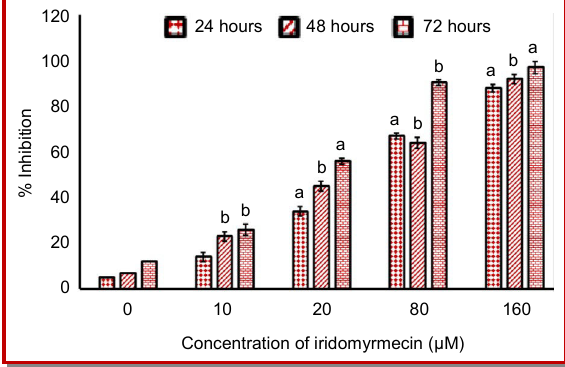
Figure 1: Inhibition of cell proliferation by iridomyrmecin in human cervical cancer cells (HeLa). The cells were treated with increasing doses of iridomyrmecin and then anti-proliferative effect was assessed by MTT cell viability assay. Data are shown as the mean ± SD of three independent experiments. a p<0.05, b p<0.01 vs 0 µM